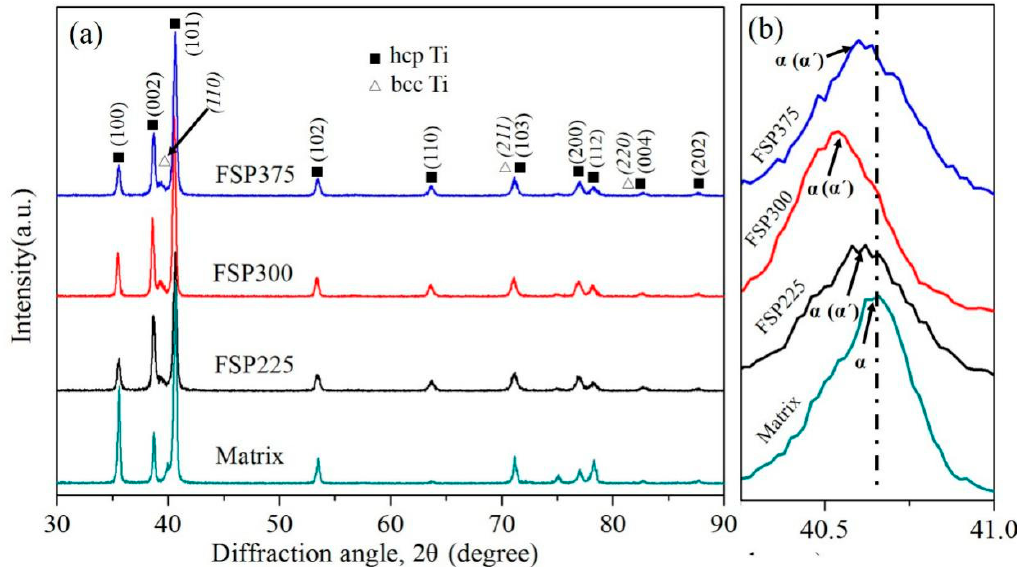
Figure 5. ( a ) XRD patterns for the specimens obtained under different rotation rates, and ( b ) Magnified image in ( a ) between 40° and 41°.